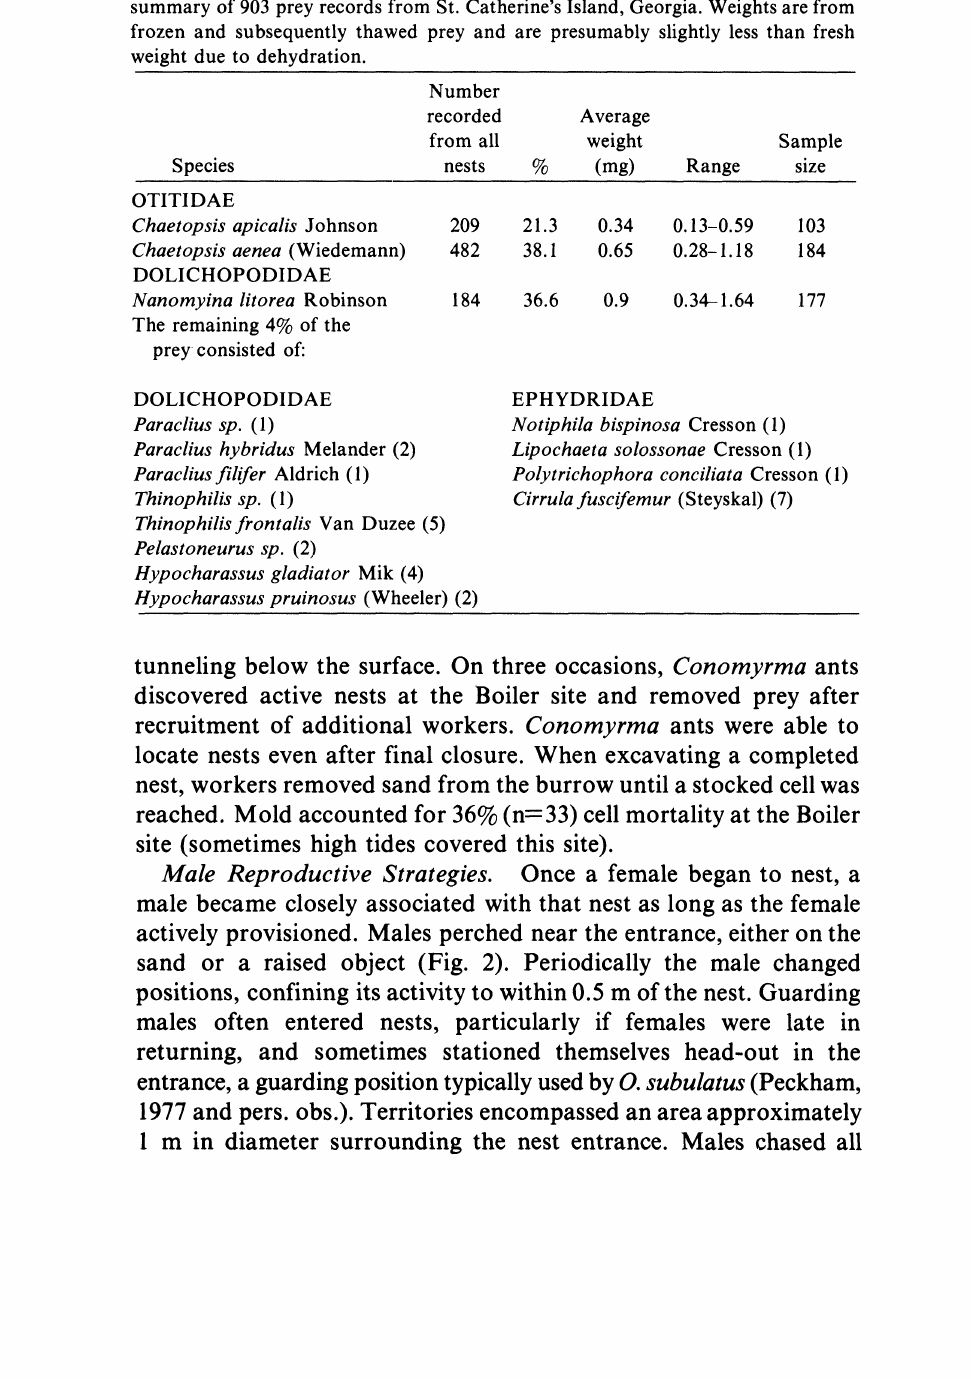
Table 1. Prey weights for most abundant prey captured by Oxybelus sericeus and a summary of 903 prey records from St. Catherine’s Island, Georgia. Weights are from frozen and subsequently thawed prey and are presumably slightly less than fresh weight due to dehydration. Number recorded Average from all weight Sample Species nests